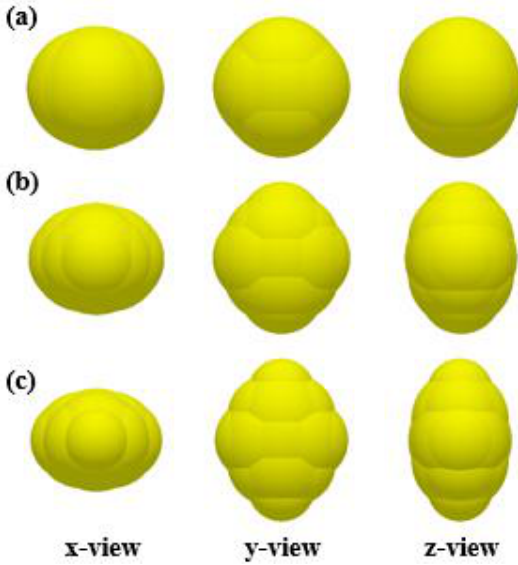
Figure 8. The 13-sphere model of ( a ) SN42, ( b ) JD17, and ( c ) ZD39. Table 2. Parameters used in the simulation.